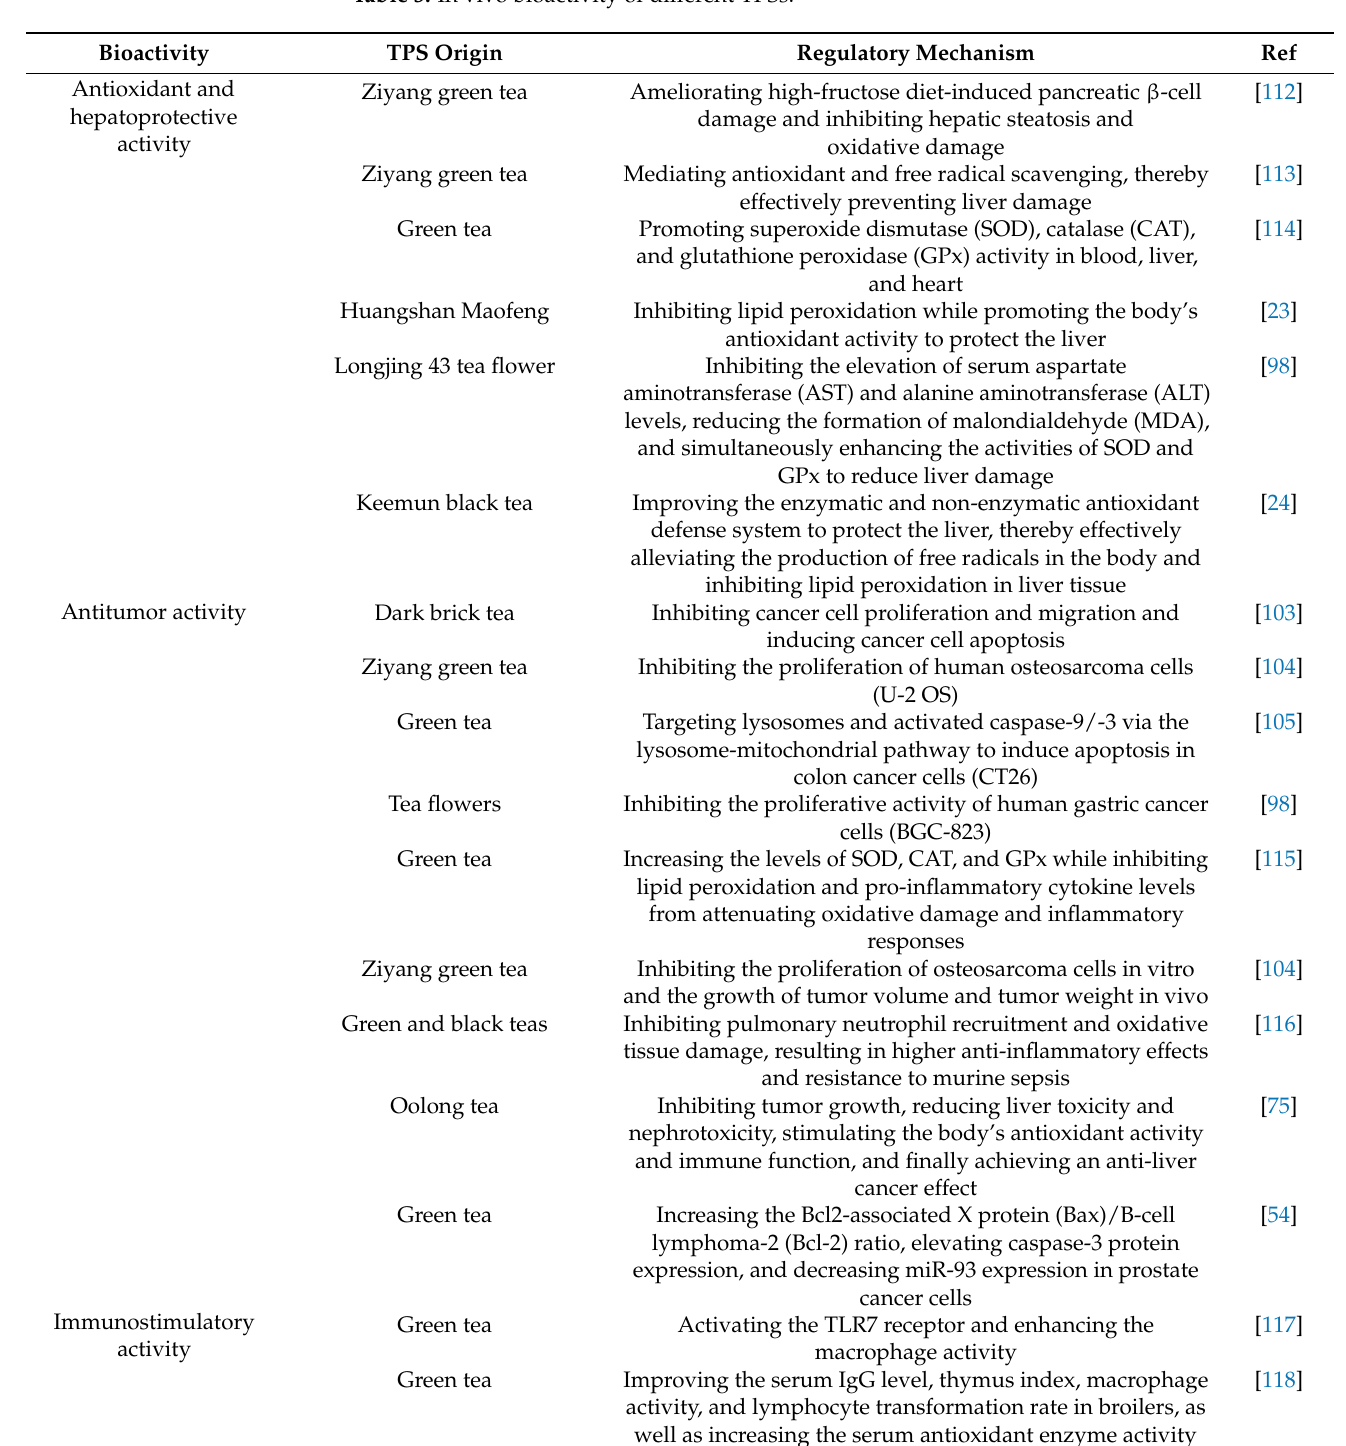
Table 3. In vivo bioactivity of different